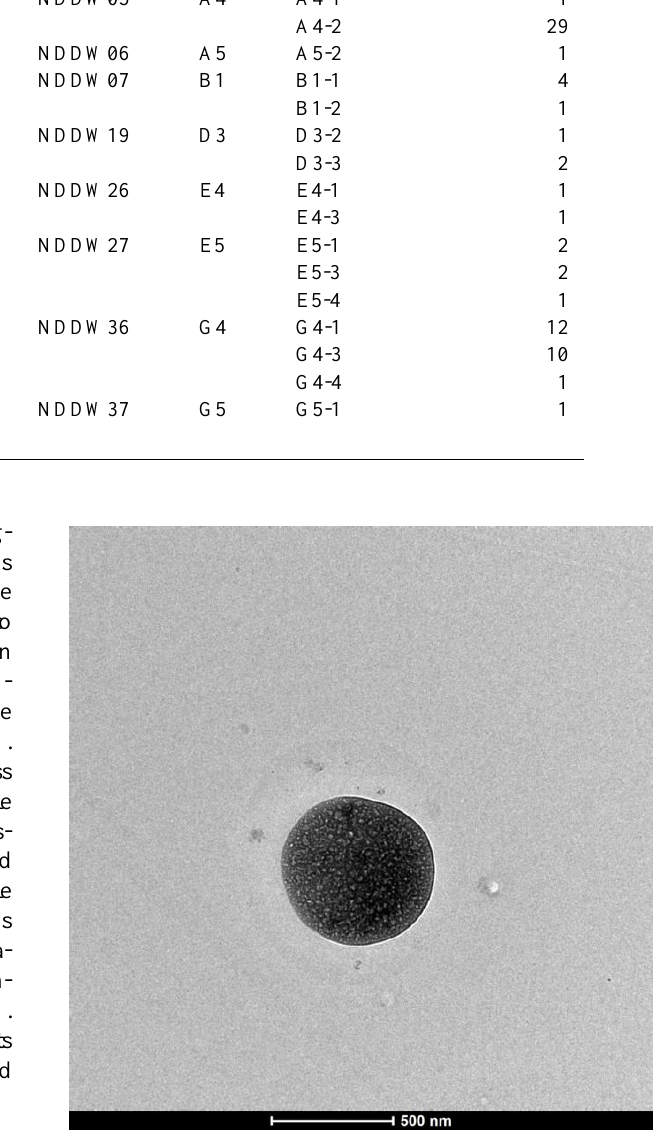
Figure 1. TEM image of an S-, O-, and Si-containing particle ob- tained from an ascending gas flow above the soil over the Dong- shengmiao